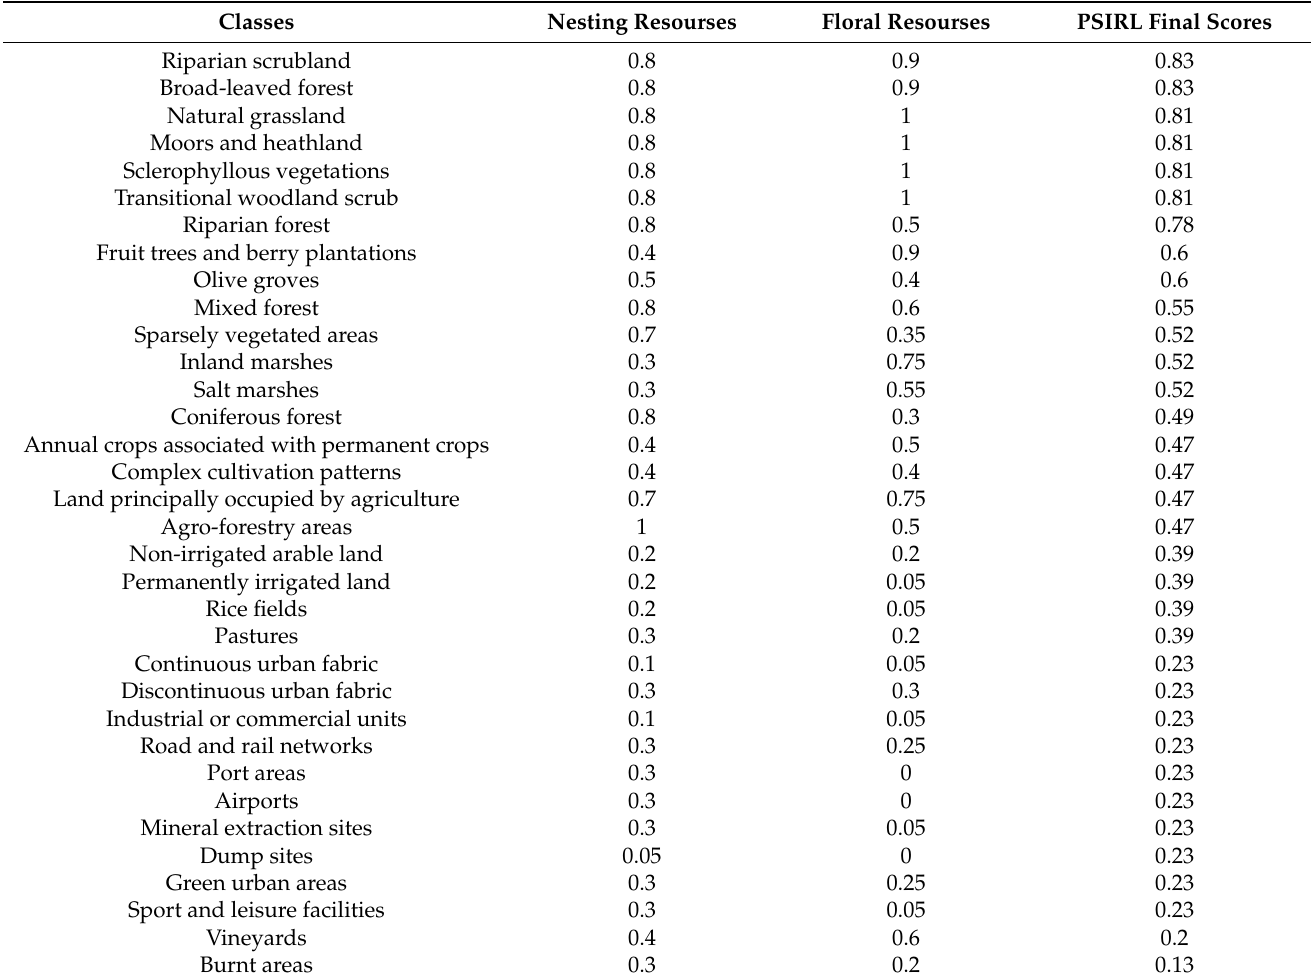
Table A1. Land Use Land Cover (LULC) classes, parameterization of the biophisical table for the InVEST model (nesting and floral resources), and PSIRL final scores used in